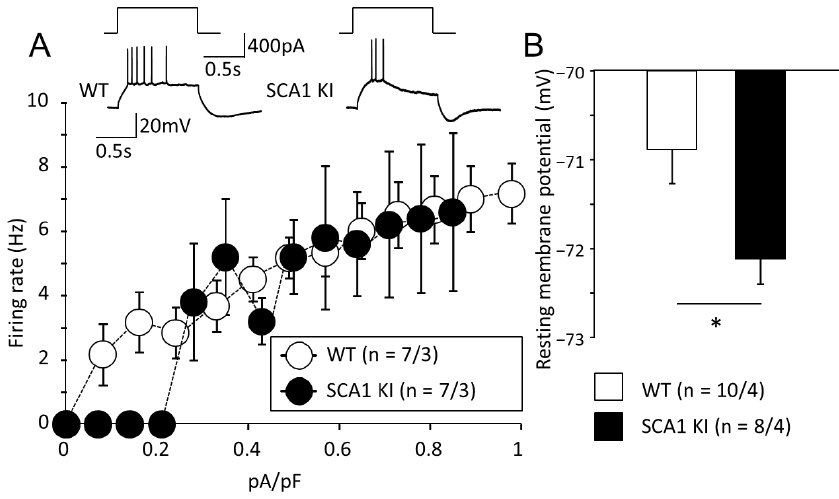
Figure 6. PCs from SCA1 KI mice are less excitable and slightly hyperpolarized. ( A ) The firing frequencies (in Hz) are plotted against the injected currents corrected for the membrane capacitance (pA/pF). Representative traces after the same current injection are shown above the graph. ( B ) Resting membrane potentials of PCs. The numbers ( n ) of tested PCs and animals (PCs/animals) are shown in parentheses. Asterisks indicate a statistically significant difference compared with WT control mice ( t -test; * p < 0.05). These results point to a lower excitability of the diseased PCs which is likely to affect the open- ing of VGCC and could contribute to a weaker peak DSE. On the other hand, the maintenance of DSE clearly depends on the health of the BG.